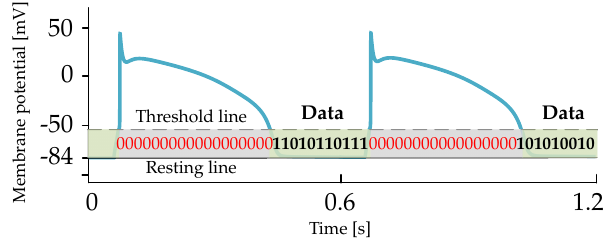
Figure 2. Encoding subthreshold membrane potentials are envisioned to be transmitted over cardiac cellular infrastructure within time bins between consecutive action